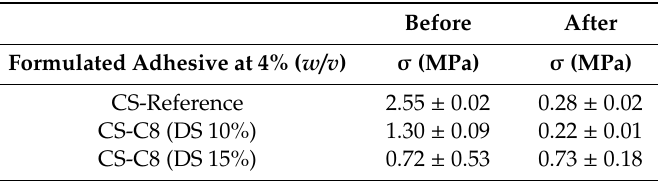
Table 2. Mechanical properties of native and alkyl-chitosan at 4% ( w / v ) before and after immersion test of wood bonded specimens. σ corresponds to the bond strength (MPa) Before After Formulated Adhesive at 4% ( w / v